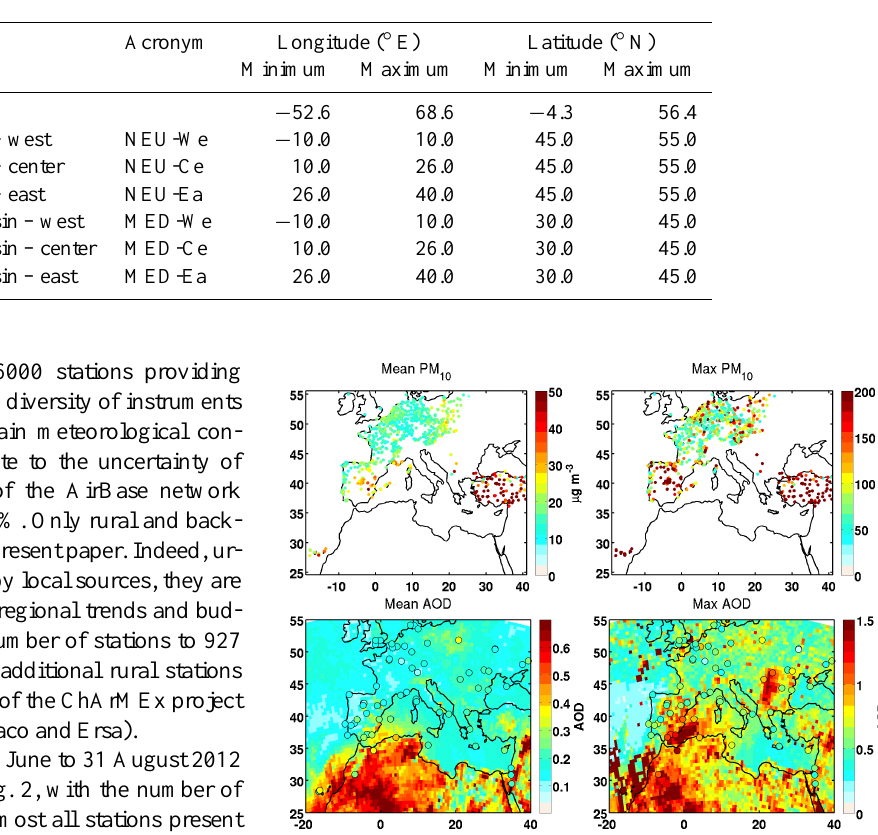
Table 1. Coordinates of the simulation domain and sub-domains used for further analysis.